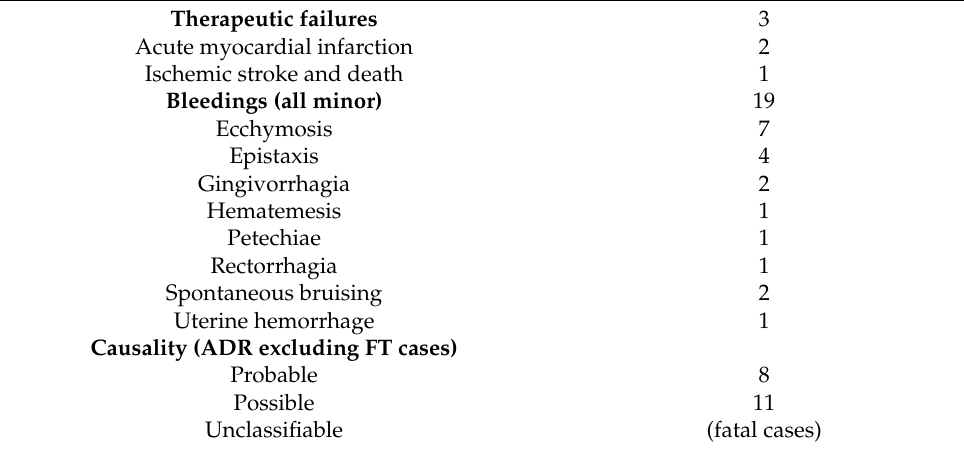
Table 3. Clinical adverse reactions and causality